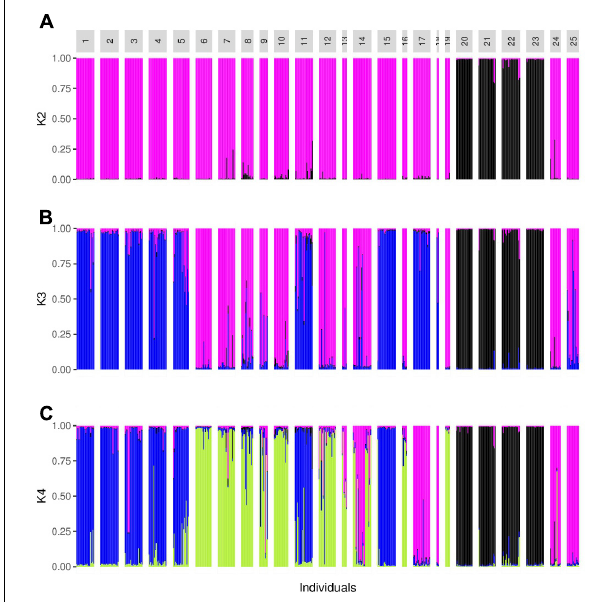
FIGURE 3 | Barplot from the Structure analysis. (A–C) K = 2, K = 3, and K = 4. Population ID are as shown in Table 1 .